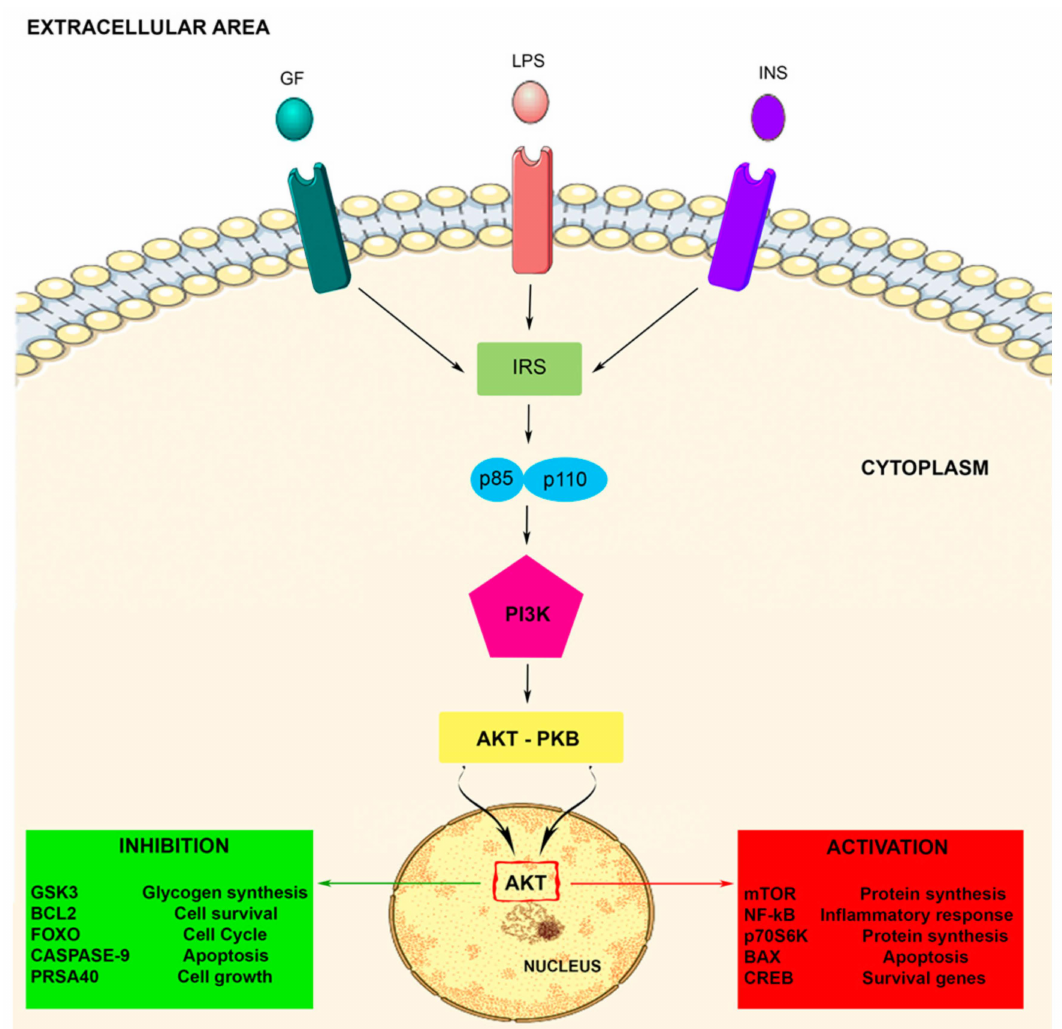
Figure 1. The PI3K-Akt signaling pathway. The PI3K-Akt pathway is involved in some crucial cellular processes including protein synthesis and cell proliferation and survival. The PI3K / Akt pathway